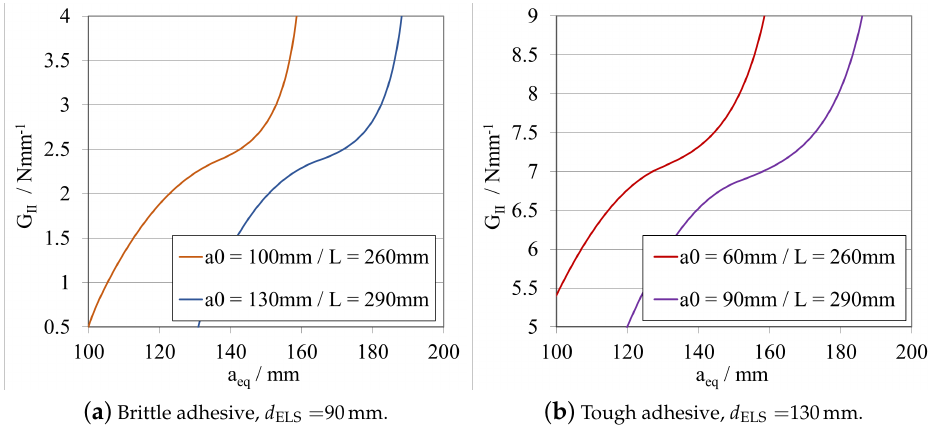
Figure 15. R-curves related to different combinations of a 0 ELS and L ELS , to attain the same d ELS .